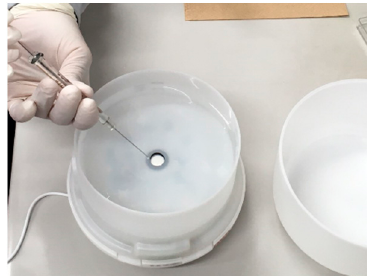
Figure 2. Preparation of diffusing and collecting test: Dropwise 0.5 mL of essential oils and effective component to 350 mL water in the aroma diffuser.